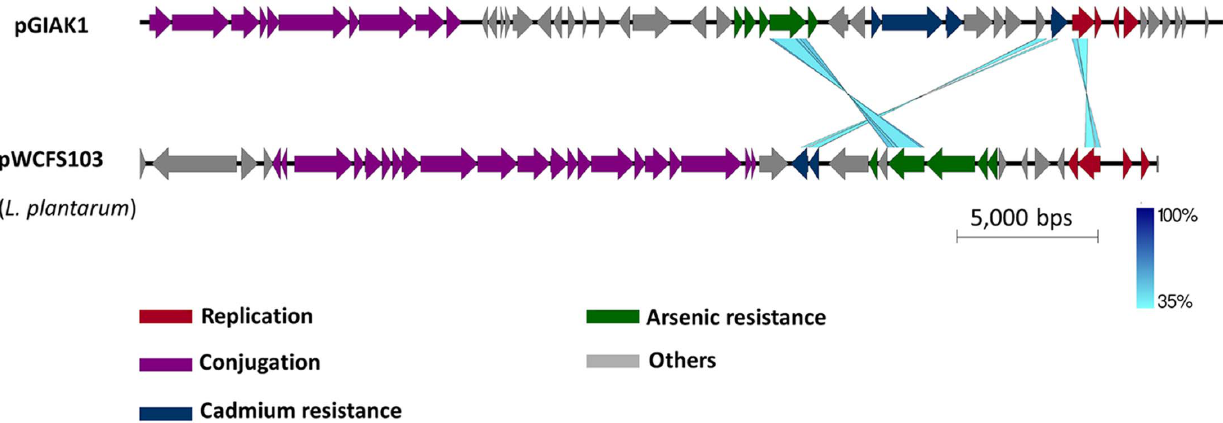
Figure 3. Comparison of pGIAK1 and the heavy metal resistant plasmid pWCFS103 from L.plantarum . The displayed bar represents a length of 5,000 basepairs. The conserved regions are blue-shaded, the color intensity indicating the identity levels (from 35 to 100%). Genes that displayed homologies are indicated by the colored boxes shown below. The alignment was made by the Easyfig 2.1 program [49] .